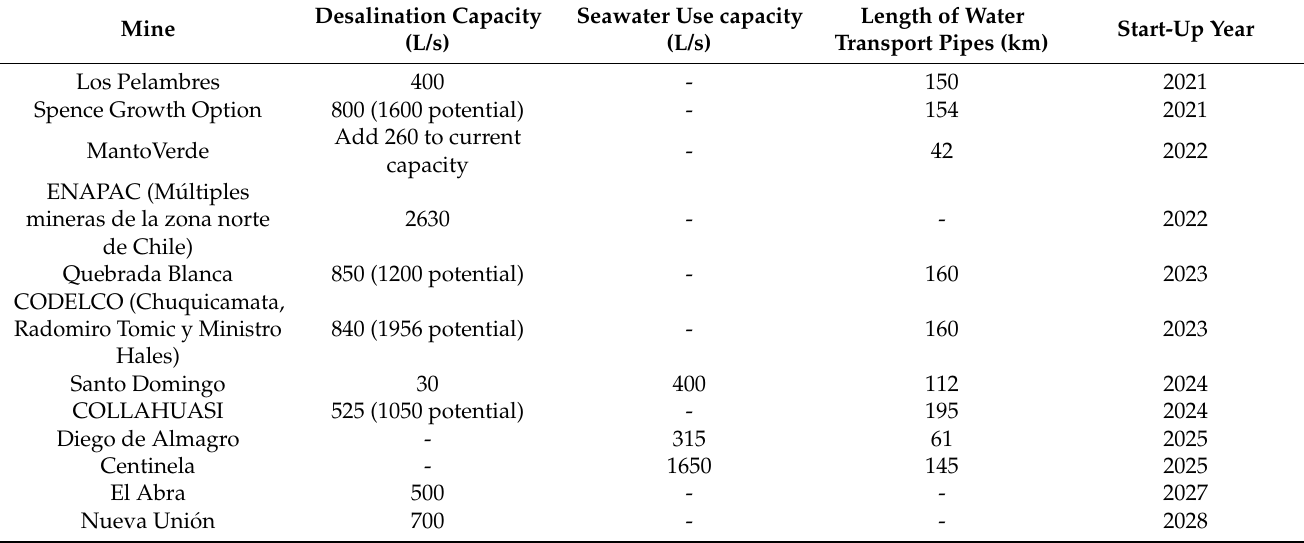
Table 4. Future projects of desalination plants and seawater impulsion systems in copper mining (Data from: